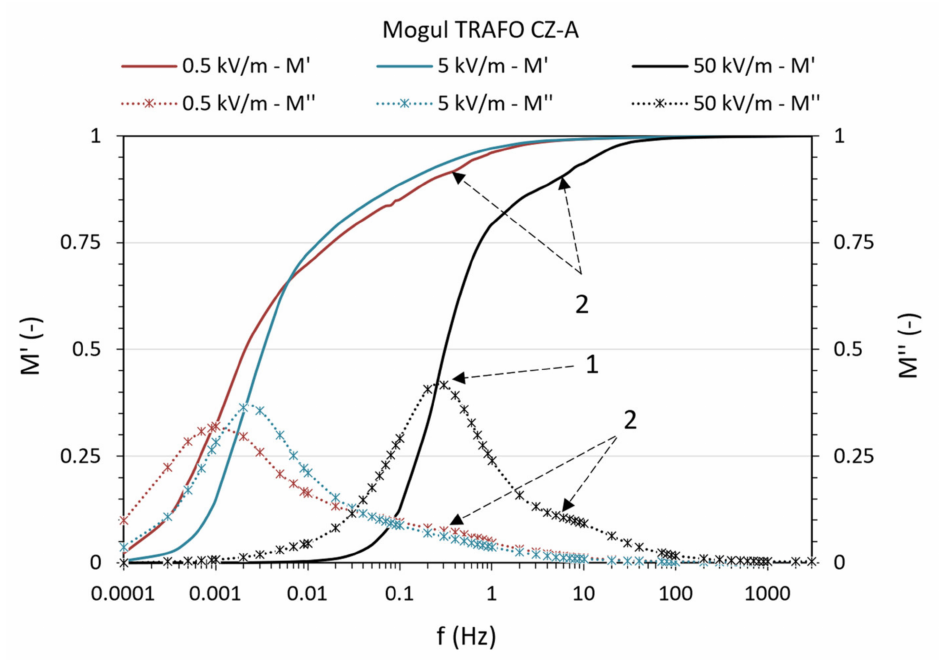
Figure 3. Complex electric modulus M* of MO oil in the frequency band.